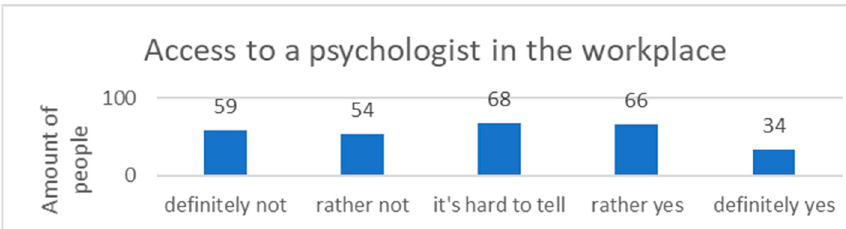
Figure 3. Access to a psychologist in the workplace.